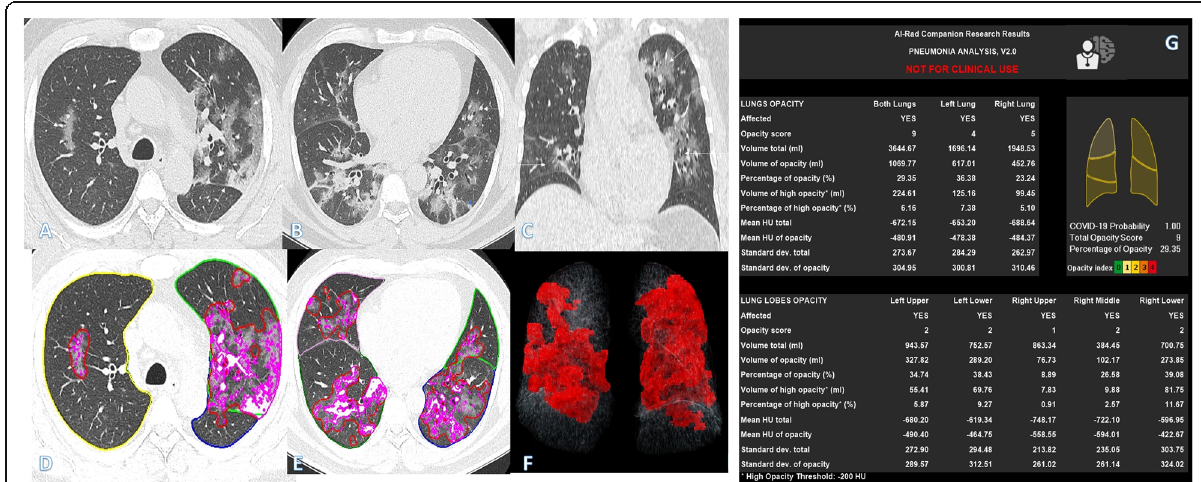
Fig. 4 A 54-year-old male with positive COVID-19 virus. CT chest shows bilateral scattered random ground-glass opacities and consolidation patches with air bronchogram (arrows) with more involvement of the left upper and both lower lobes (arrows in a – c ). Total severity score = 8. Quantitative analysis by AI-Rad Companion Research CT Pneumonia Analysis was presented ( d – g ) with the measured parameters seen in table ( g ). Quantitative total opacity score was 9